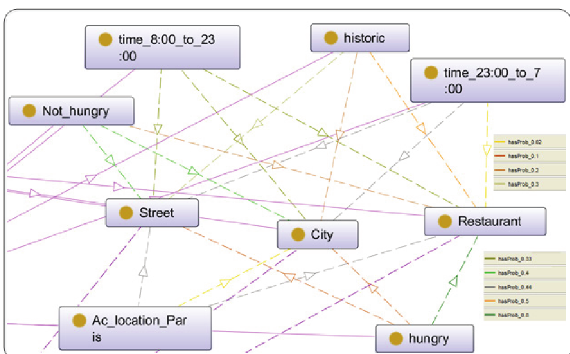
Fig. 7. Bayesian Network for